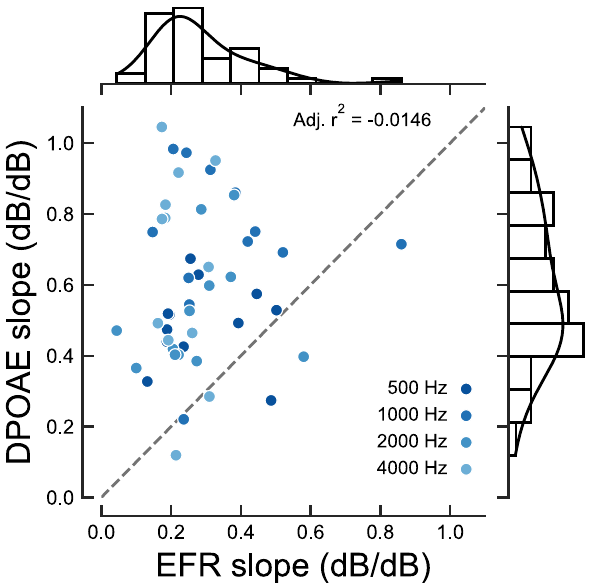
Figure 6. Relation between EFR slopes and DPOAE slopes in the same NH listeners. Frequencies are indicated as different intensities of blue colour. The dashed dark-grey line show a 1:1 ratio. Top and right marginal histograms and kernel density functions show the EFR and DPOAE slopes distributions (pooled across frequency),